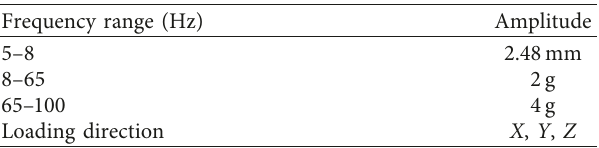
Figure 14: Comparison of the modified 7th order simulation mode and test mode shapes for the first 7 orders. Table 6: Sine sweep loading conditions.